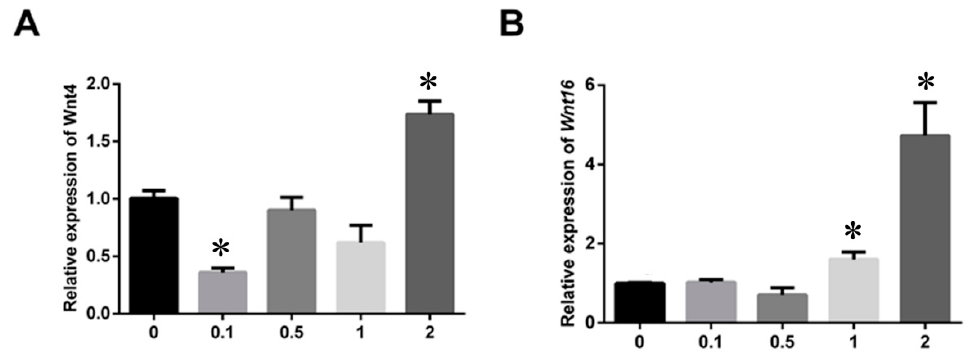
Figure 7. Effects of nanoplastics on mRNA levels of DpWnt4 ( A ) and DpWnt16 ( B ) genes after 21 days. Values are represented as means ± SE, asterisks indicate significant differences ( p < 0.05).